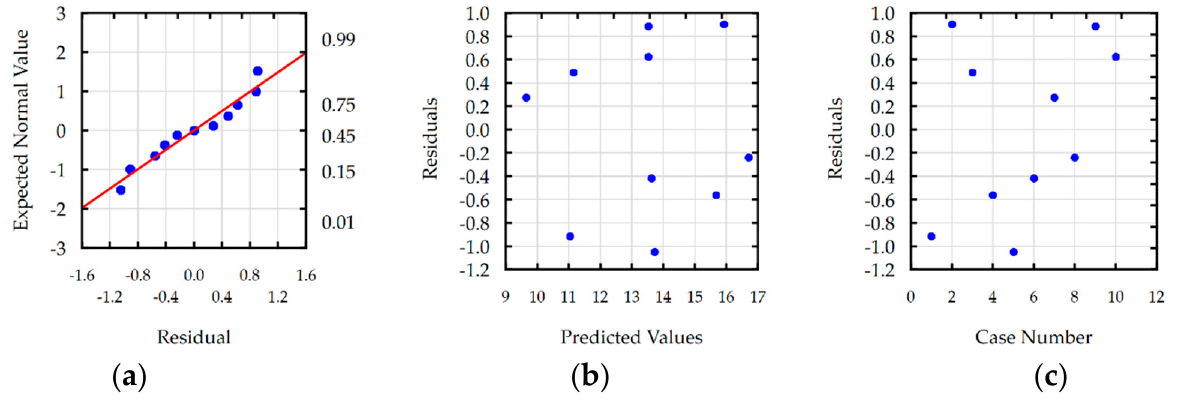
Figure 8. Plots for the model of surface roughness: ( a ) the normal plot of residuals; ( b ) the residuals versus the predicted values; and ( c ) the residuals versus the case number.